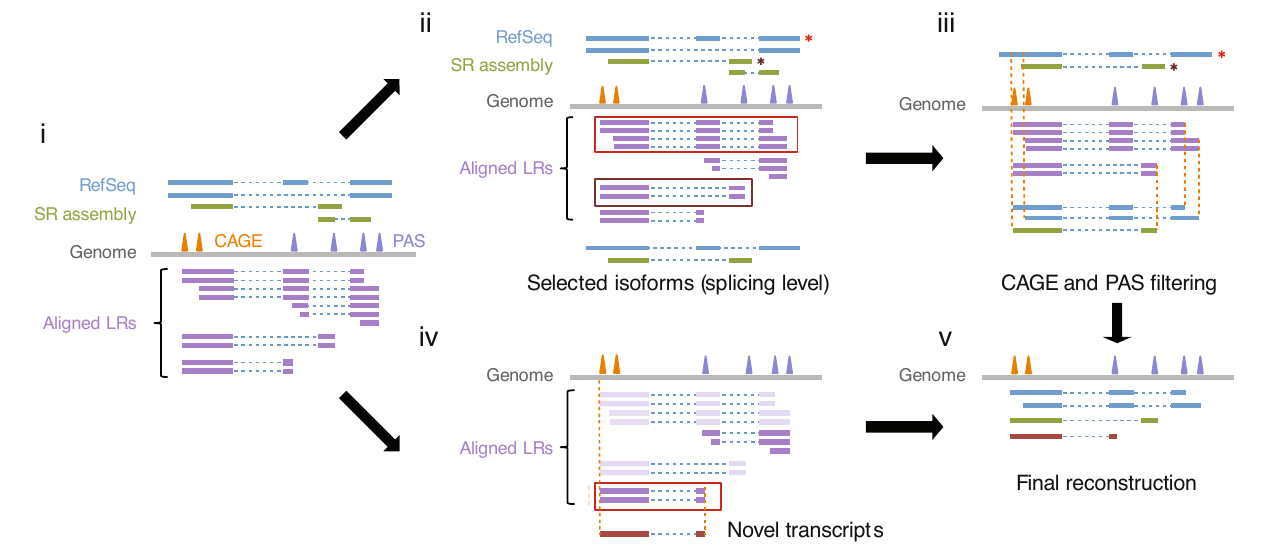
Fig. 1 Pipeline for identifying intact transcripts in mouse sperm. The reconstruction of the transcriptome involved fi ve steps. Step i : We compared the successfully aligned long reads (LRs) with the RefSeq annotation of mm10 and assembled the short reads (SRs) using StringTie (version 1.3.1c, parameters -c 10 -p 10) 95 . SRs from sperm and testis were assembled separately and the two assemblies were then merged using StringTie again (the “ merge ” mode). Peaks from CAGE and PAS-seq were de fi ned by AS-peak 96 . Step ii : Select isoforms that can be supported by any splicing patterns in RefSeq or SR assembly. It should be noted that we did not impose any restriction at the 5 ′ - or 3 ′ -end at this stage. Step iii : Correct the ends of isoforms by CAGE and PAS peaks. Step iv : Novel isoforms were de fi ned by selecting LRs that are not supported by either RefSeq or SR assembly. These isoforms must have CAGE and PAS peaks to support their ends. Step v : Final assembly contains well annotated intact RNAs in